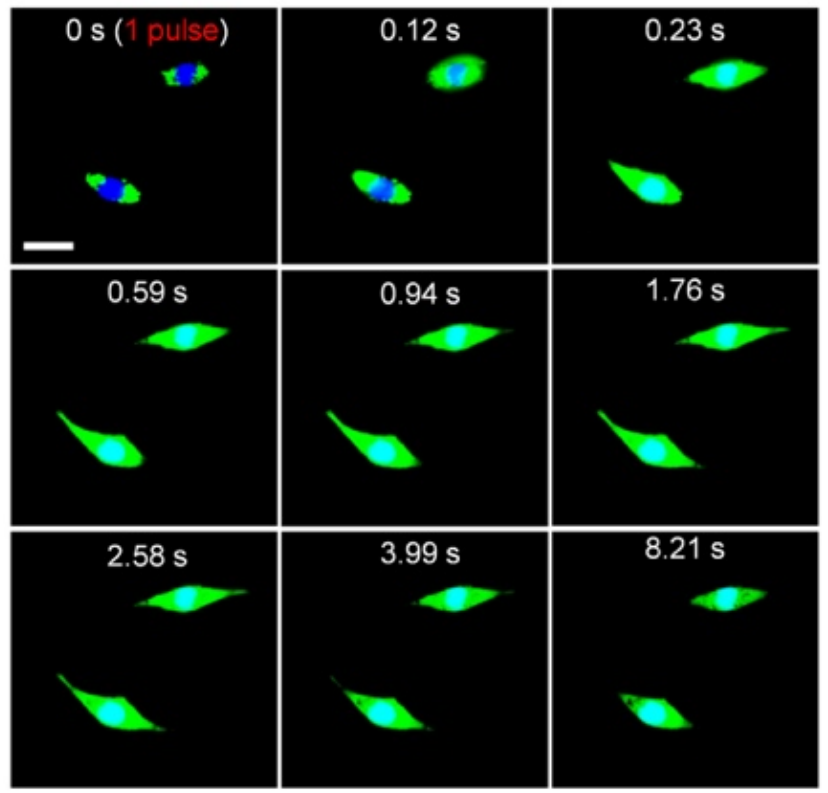
Figure 16. Calcein fluorescence intensity distribution following a single NIR laser pulse. Gold- coated liposomes encapsulating calcein were endocytosed (Figure 15) into RAW 264.7 cells and the endosomes and liposomes ruptured by a single NIR light pulse. The rapid spreading of the calcein dye is indicative of efficient endosome escape. The cells show minimal toxicity for the appropriate NIR fluence, although higher fluences can be used to kill the cells. Bar is 10 µ m, and the magnification is the same in all images. Adapted from [47], published by Wiley, 2020. Figure 17 shows that rapid endosome escape via NIR light pulses can release sec- ond messenger molecules and trigger complex intracellular functions. Inositol 1,4,5- trisphosphate (IP3) is a second messenger for intracellular calcium ion signaling [47]. IP 3 was encapsulated within gold-coated liposomes and incubated with RAW 264.7 cells, as in Figure 15, leading to endocytosis. IP 3 in the cytosol binds to a receptor located on the endoplasmic reticulum membrane, which causes calcium release from the endoplas- mic reticulum into the cytosol [145]. A single pulse of NIR light releases the IP 3 from the liposomes and endosomes and causes a transient increase in the intracellular calcium concentration, as shown by the increase in Fluo-4